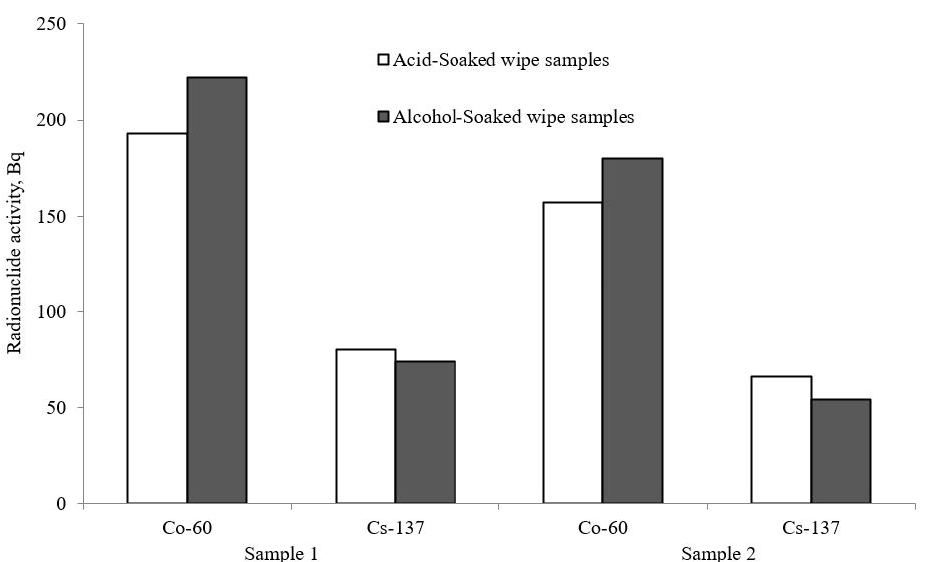
Figure 2. Comparison of radionuclide activity in ethanol- and acid-soaked wipe samples taken from the surface of linear parts of the coolant pipelines. The activity of 60 Co and 137 Cs is in the range of 150–220 Bq and 50–80 Bq, respectively. The activity levels almost do not differ between the acid- and ethanol-soaked wipe samples.